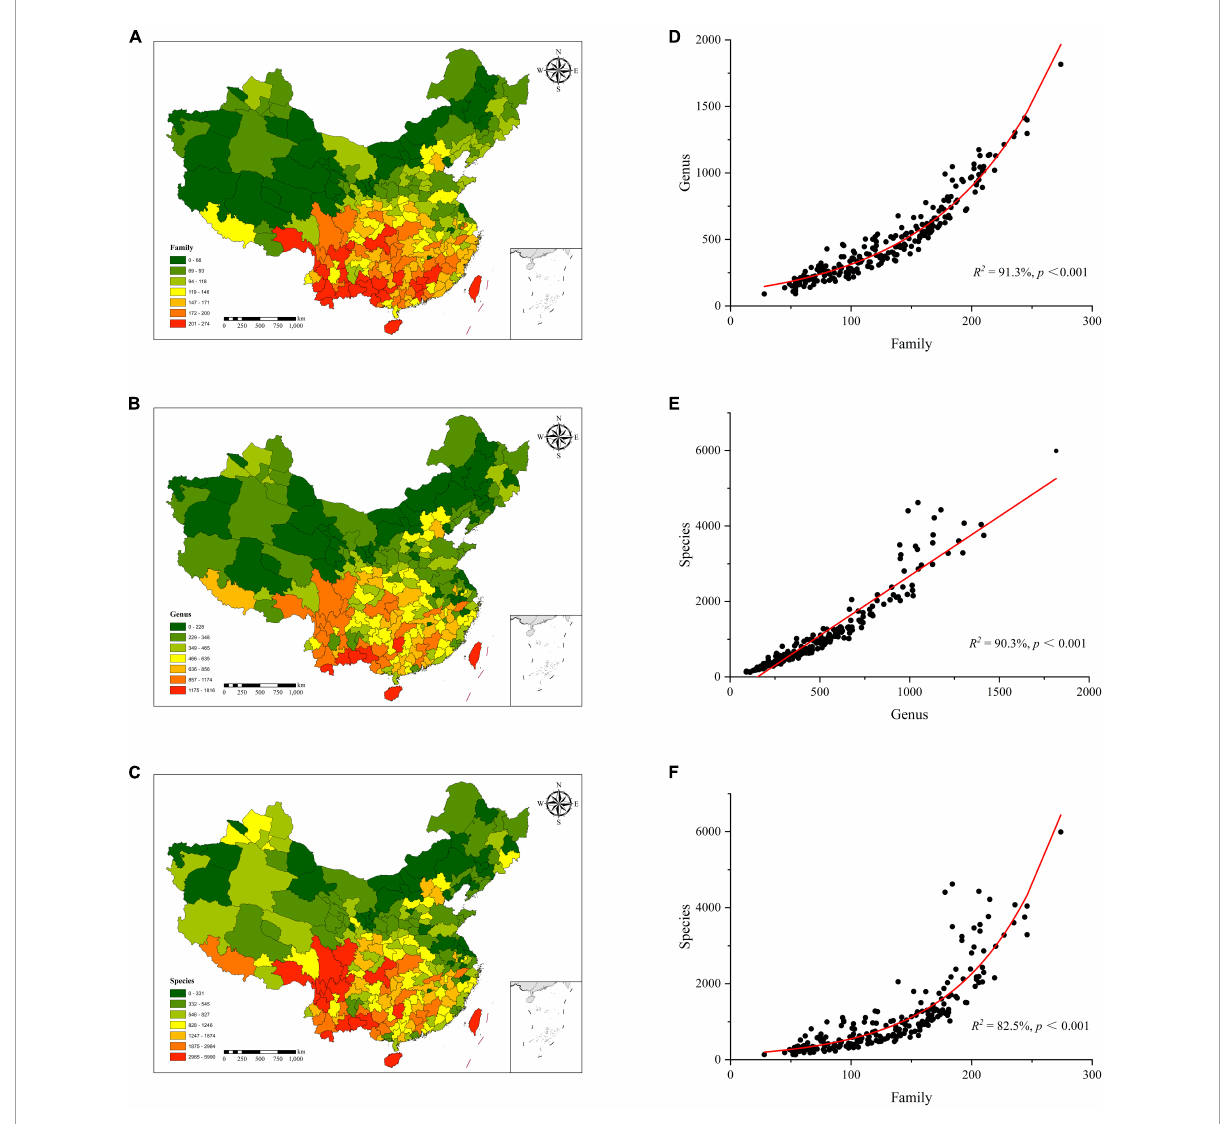
FIGURE2 Plant diversity distribution patterns at family (A) , genus (B) , and species (C) . (D) plant family diversity vs. plant genus diversity, (E) plant genus diversity vs. plant species diversity, (F) plant family diversity vs. plant species